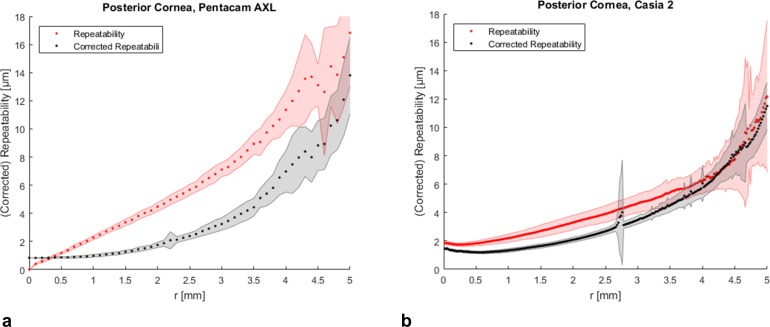
Repeatability and corrected repeatability of posterior corneal elevation.(a) Repeatability (red) and corrected repeatability (black) of posterior corneal elevation data maps obtained with Pentacam AXL and (b) CASIA 2 (right) averaged along concentric rings ± standard deviation (shaded area) as a function of the radial distance r from the corneal apex.